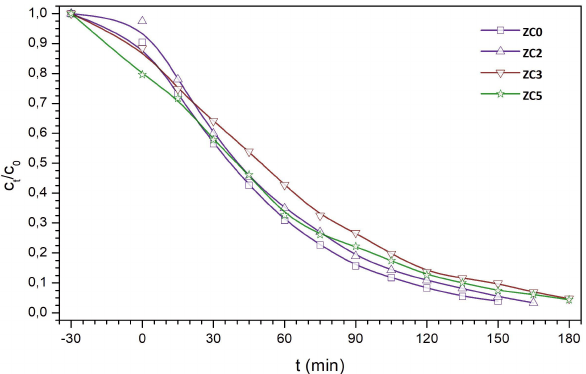
Figure 9: Photocatalytic discoloration of MB over prepared catalysts at room temperature. The lines are introduced as a guideline for the